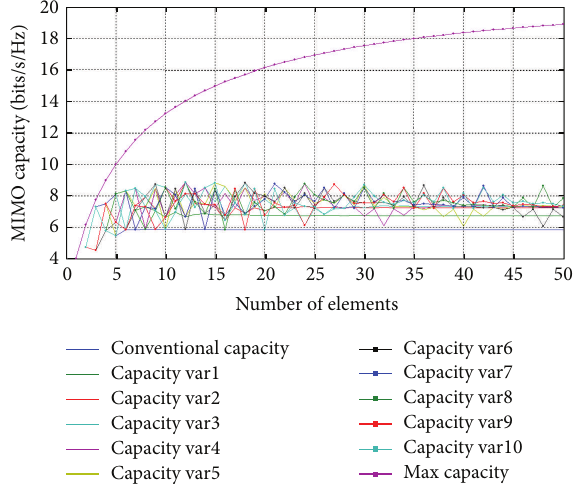
Figure 12: MIMO capacity for the spiral geometry with a SNR = 15dB and a radius of 0.1 𝑑